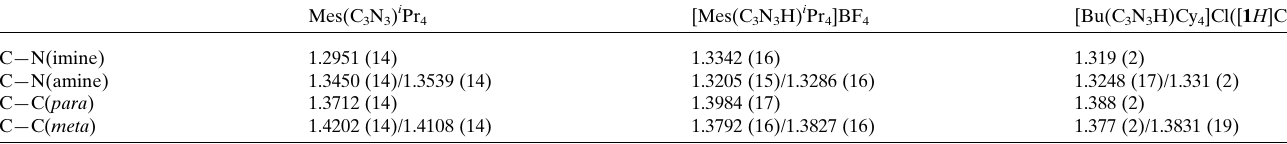
Table 1 Comparative bond lengths (A˚ ) for 1-mesityl-2,3-bis(diisopropylamino)cyclopropenimine, 1-mesityl-2,3-bis(diisopropylamino)cyclopropeniminium (Bruns et al. , 2010), and N - n -butyl-2,3-bis(dicyclohexyl)cyclopropeniminium. Divided entries refer to separate, related pairs of atoms and their associated metrics, e.g. , 1.3450 (14)/1.3539 (14) denotes two distances for the two C—N(amine) contacts.